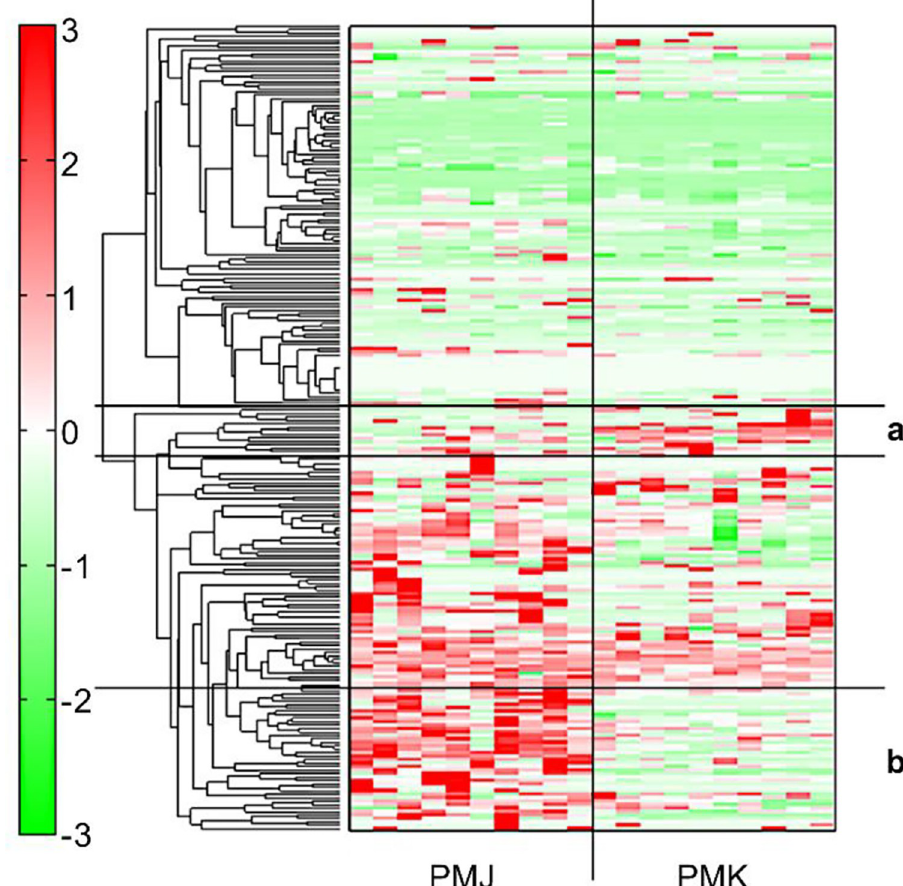
Fig 2. Heatmap of metabolome data from Japanese and South Korean red seabream muscle samples. The horizontal and vertical axes represent the sample names and peaks, respectively. Hierarchical clustering analysis was performed on the peaks. The distance between peaks is displayed in tree diagrams. Among the 233 metabolites, upregulated metabolites are indicated in red and downregulated metabolites are indicated in green. South Korean red seabream muscle samples (PMK, n = 10) are represented in cluster a, and Japanese red seabream muscle samples (PMJ, n = 10) are represented in cluster b.